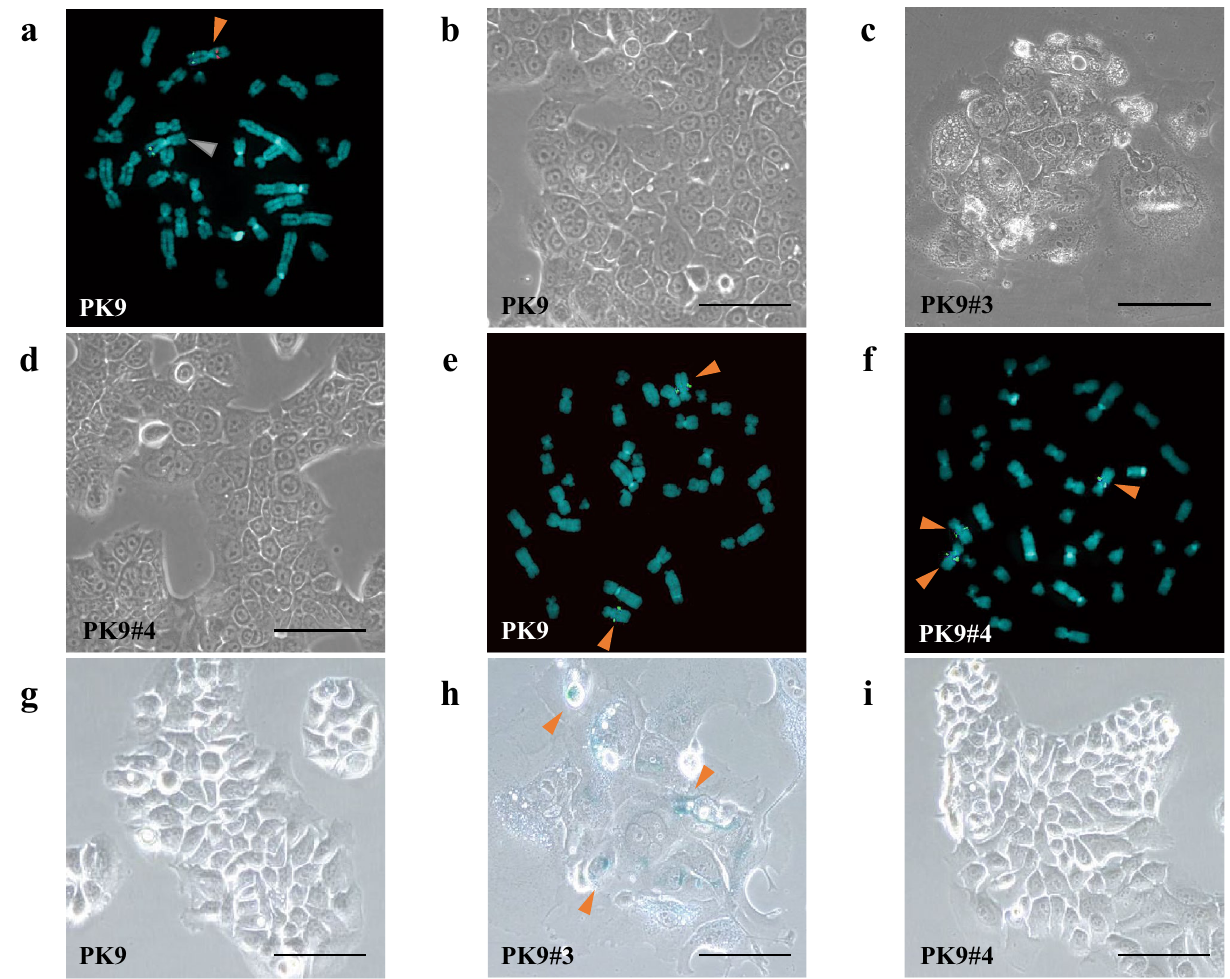
Figure 1. PK9 cells have monoallelic deletion at the 3p21.3 region, and PK9 microcell hybrids with human chromosome 3 could not be established due to arrested cell proliferation. ( a ) Fluorescence in situ hybridization (FISH) analysis of human pancreatic cancer PK9 cells in metaphase. Rhodamine-labeled RP-6 234N4 pPAC4 clone containing the human chromosome 3p21.3 genomic DNA and FITC-labeled RP11-82C9 BAC that included the 3q26.2 region were used as probe DNA. The orange arrowheads indicate a normal human chromosome 3 which has both rhodamine and FITC signals. The gray arrowhead points out an abnormal chromosome 3 with only the FITC signal. The morphology of ( b ) parental PK9 cells and ( c ) G418-resistant PK9 microcell hybrids with human chromosome 3 (PK9#3). Scale bar 100 µm. FISH analysis of ( d ) PK9 cells and ( e ) PK9#4 cells. FITC-labeled RP11-84C13 BAC clone that included the 4q22.1 region was used as probe DNA. The arrowhead indicates parental and transferred human chromosome 4. ( f ) The morphology of PK9#4 cells. Scale bar 100 µm. Images of β-galactosidase staining of ( g ) parental PK9 cells, ( h ) PK9#3 cells, and ( i ) PK9#4 cells. The arrowhead indicates representative SA-β-gal positive cells. Scale bar 100